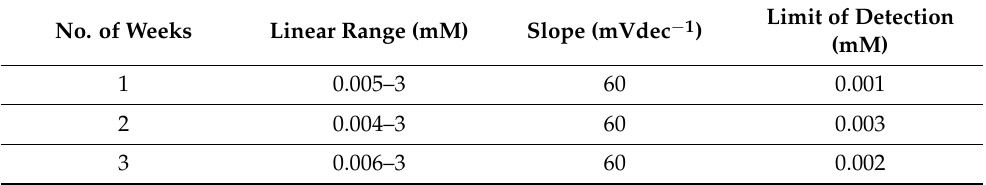
Table 1. Storage life of cholesterol oxidase-immobilized Co 3 O 4 nanocrystals. No. of